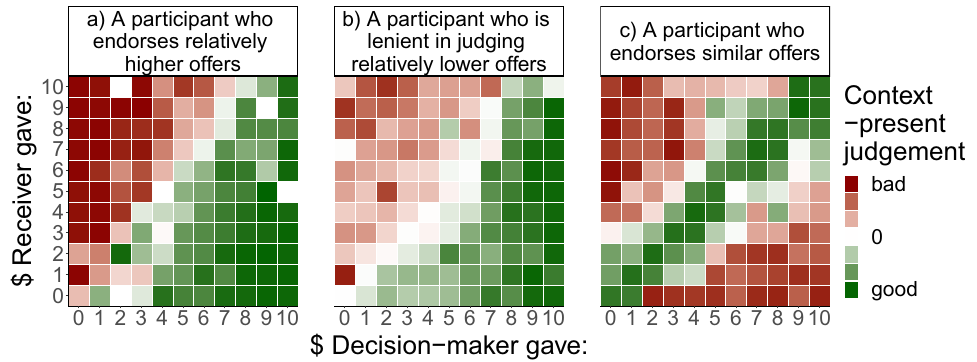
Figure 3. Context-present judgement examples. The judgement is represented by the colour of the tiles arranged in the Decision-maker’s action and context combination space. Separate plots are shown for three participants with different judgement styles, highlighting examples of ( a ) endorsing relative generosity, ( b ) lenience in judging relatively low offers, and ( c ) endorsement of indirectly reciprocal